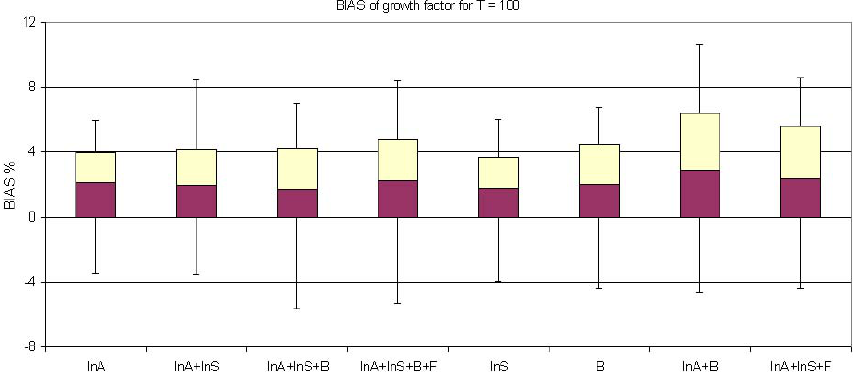
Fig. 2. Values of BIAS for the analysis summarised in Fig. 1.